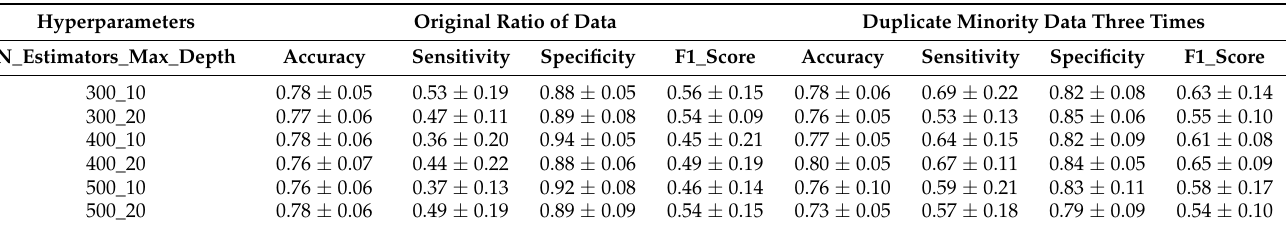
Table 3. Performance of over-sampling Data.